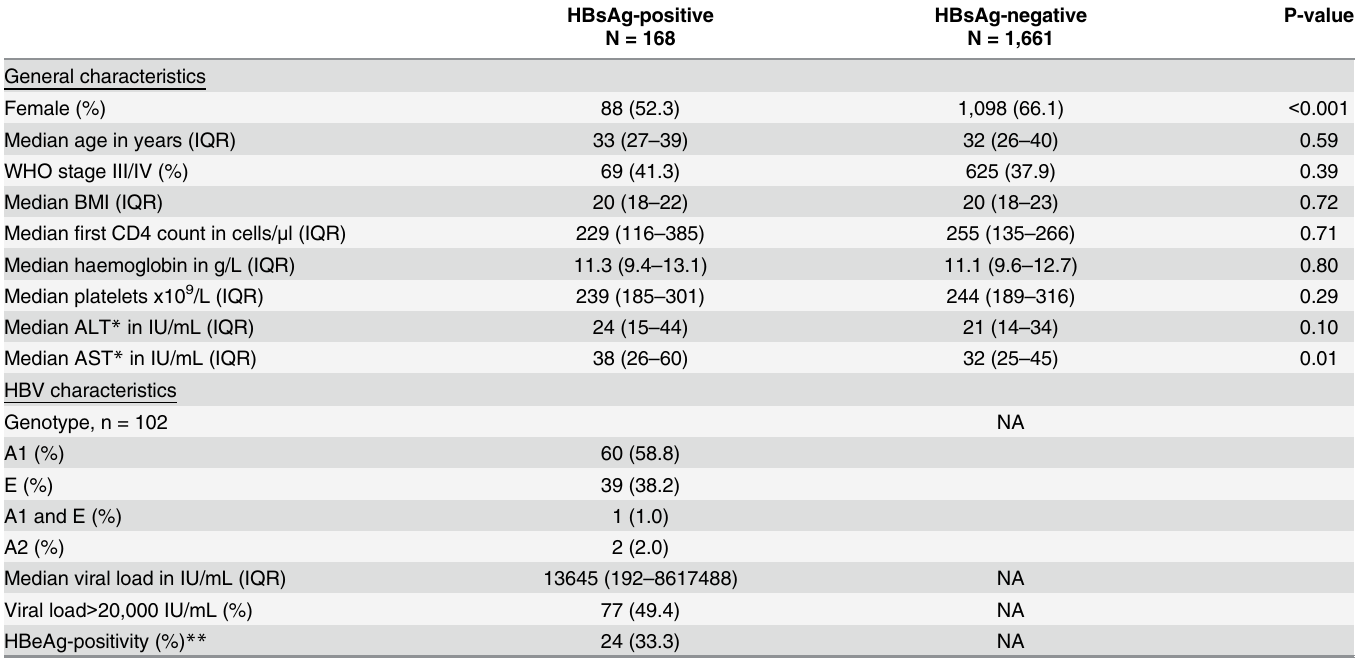
Table 1. Baseline characteristics, by HBsAg-positivity